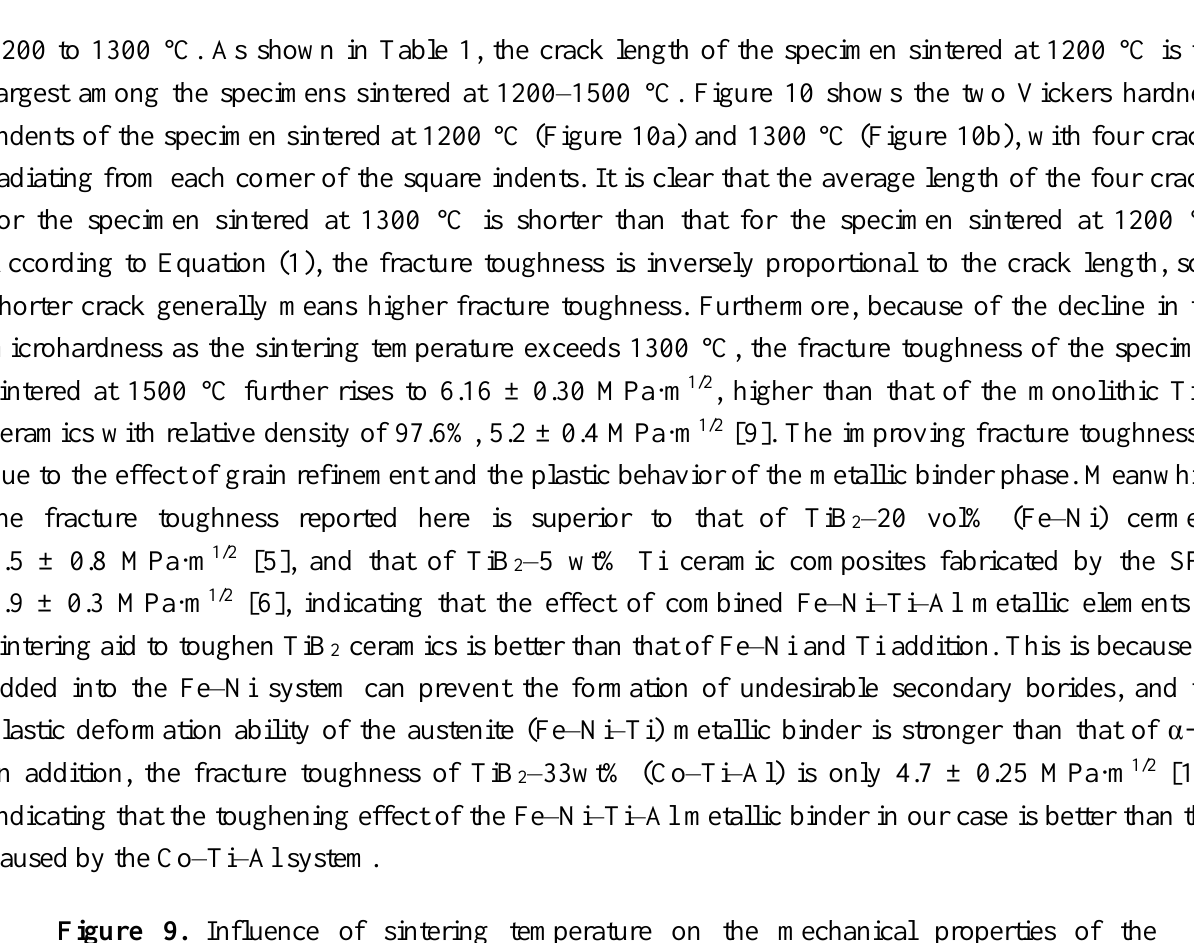
Figure 9. Influence of sintering temperature on the mechanical properties of the